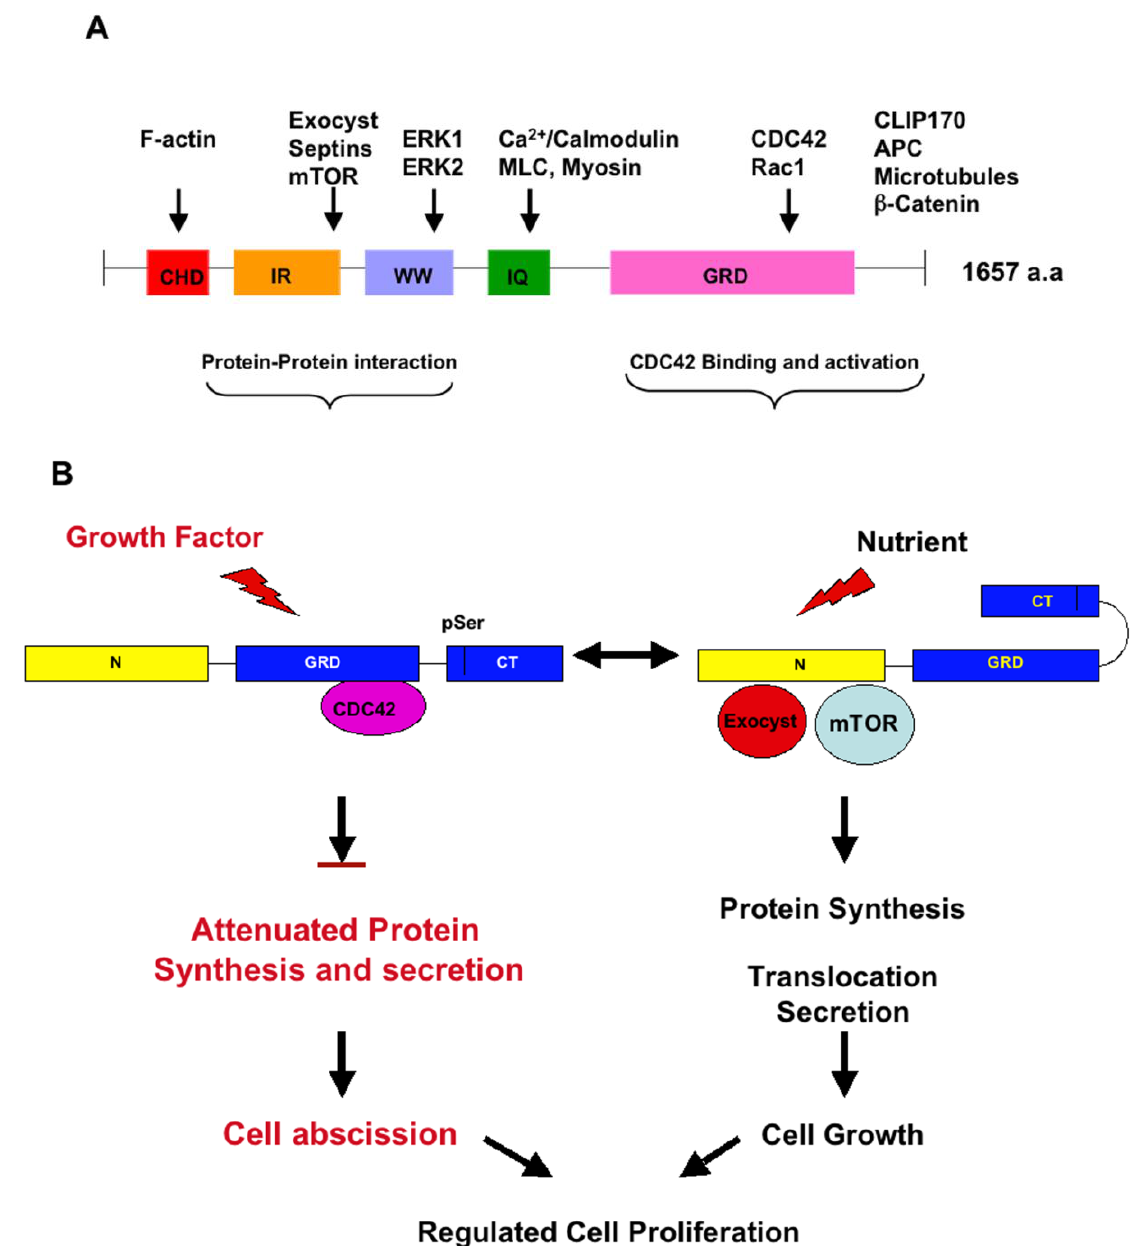
FIGURE 1. IQGAP1 is a modular, multifunctional, signaling protein. (A) Schematic representation of IQGAP1 domain structure and a list of some of its binding partners. CHD: C alponin H omology D omain; IR: specific I QGAP R epeats; WW: proline-rich domain resembling the SH3 interacting domains; IQ: 8 IQ motifs that bind Ca 2+ calmodulin and myosin; GRD: ras G AP- R elated D omain containing sequences that bind CDC42 and Rac1. (B) A hypothetical model representing the regulatory role of IQGAP1 in protein synthesis and trafficking by which it couples cell growth and division to regulate cell proliferation. IQGAP1 is a conformational switch regulated by phosphorylation and protein-protein interaction (see text for detail). In response to nutrients, IQGAP1 operates in a closed form generated by folding of the C-terminus[29] and interaction with mTOR to promote protein synthesis, and the exocyst to promote secretion, which ultimately results in cell growth. In response to mitogenic signals, IQGAP1 is phosphorylated, leading to binding and activation of CDC42, which in turn results in attenuated secretion and cell growth and promotion of cell division[44].